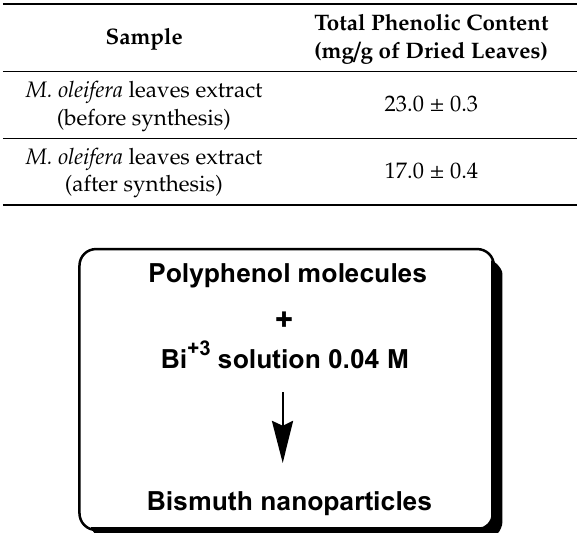
Scheme 1. Schematic representation of bismuth nanoparticles synthesis.